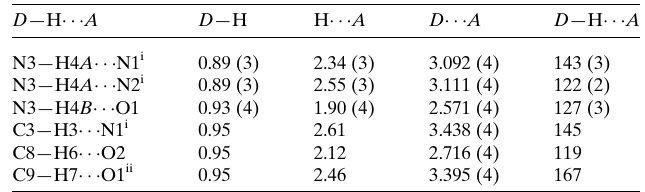
Table 1 Hydrogen-bond geometry (A˚ , (cid:2) ).